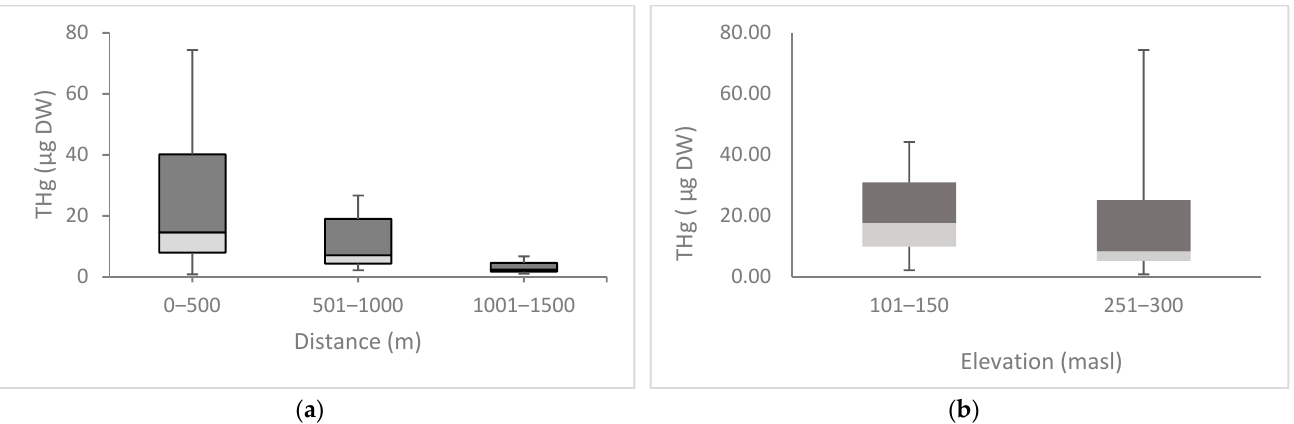
Figure 5. Boxplots distribution of THg in tree barks with variable distances ( a ) and elevations ( b